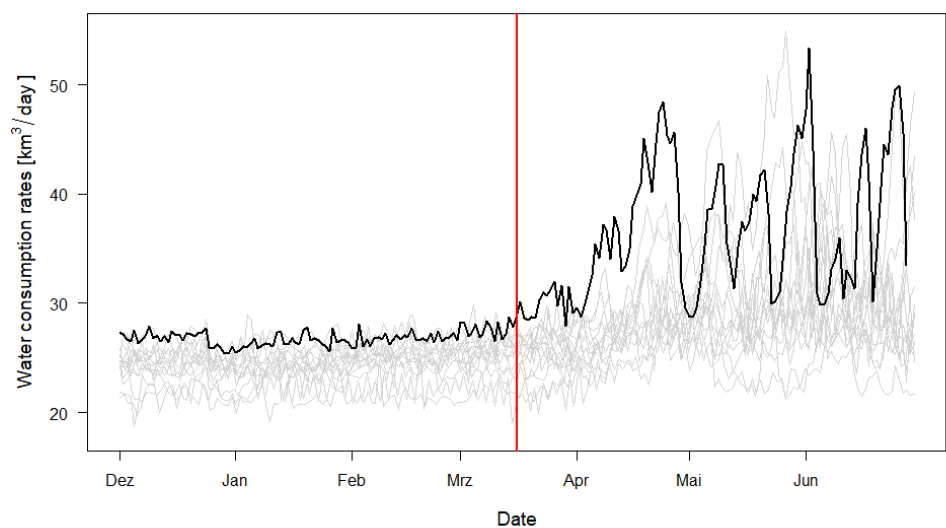
Figure 2. First seven months starting with December of each year of daily water rates provided by the WBV Harburg to the whole service area. The red line marks 16 March when all schools and daycare centers closed in 2020 [23]. At the same time, this represents the beginning of strict Corona measures. For comparison, data of all years are overlapped. Grey lines represent the years 2006–2019, black line represents 2020.